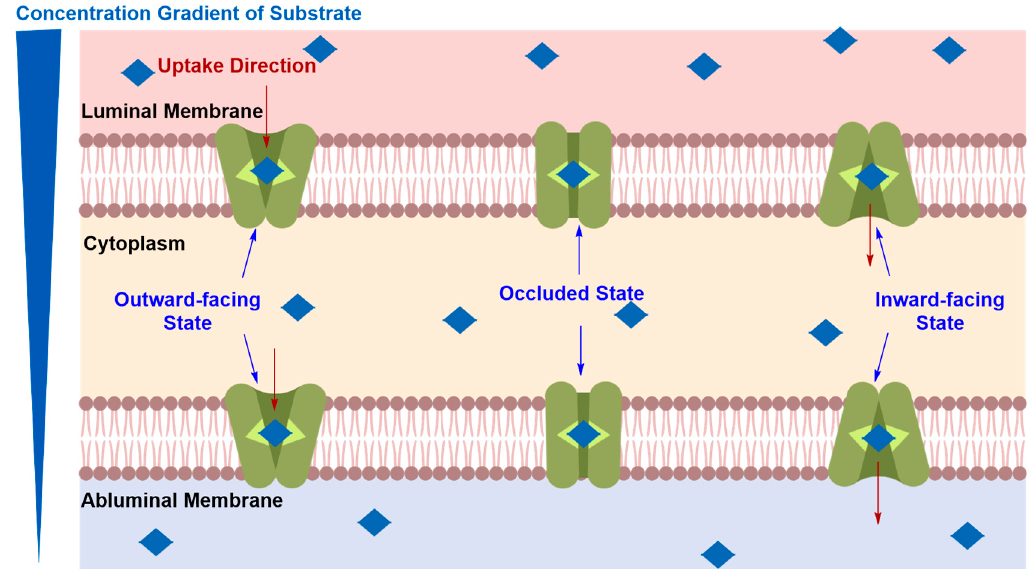
Figure 10. Postulated mechanism of carrier-mediated transcytosis (CMT). Solute carrier transporter proteins (SLC) undergo conformational change from outward to inward-facing orientation, translocating their substrates across luminal and abluminal membranes from high intravascular to low intracerebral.